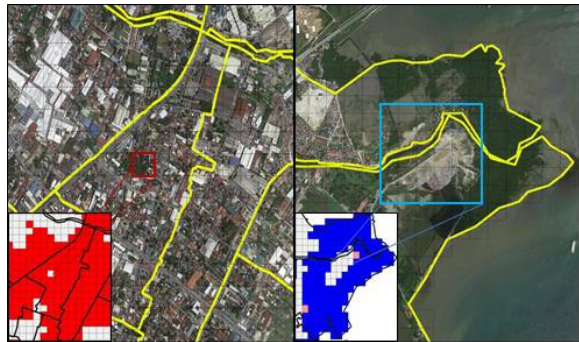
Figure 11. Grid analysis on barangay Ibabao-Estancia (left) with 93.5% hotspot pixel count and barangay Umapad (right) with 7.4% hotspot, 44.5% coldspot pixel